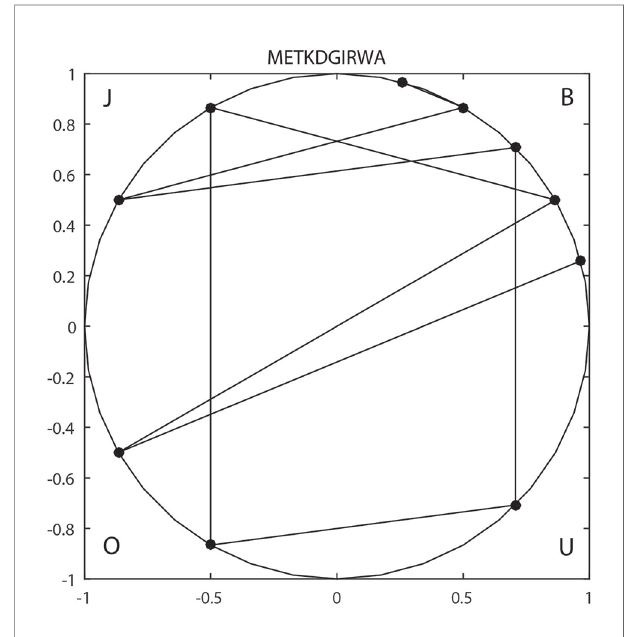
FIGURE 1 | 2-D Unit circle mapping representation of “ METKDGIRWA ” under